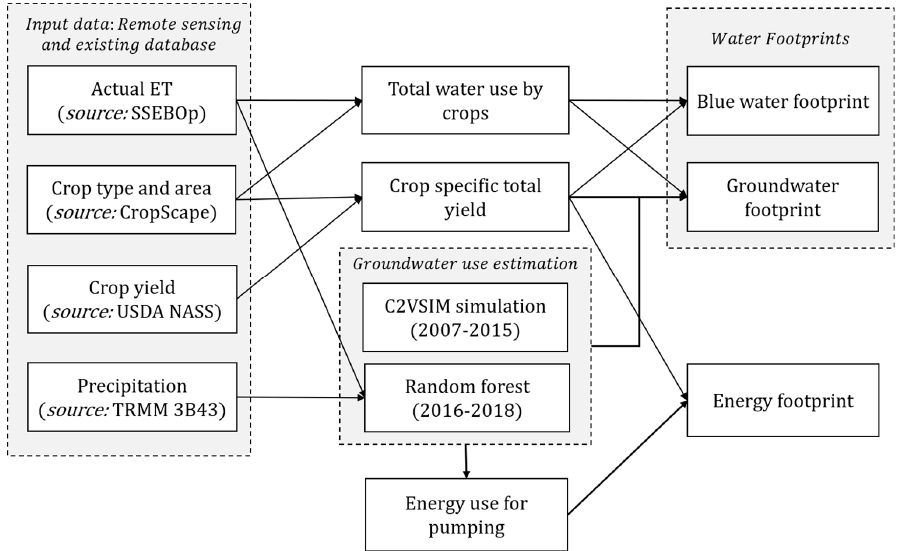
Figure 5 . Illustration of steps used to calculate water and energy footprints. Items in the gray box on the left are the data sources which are primarily remote sensing products.